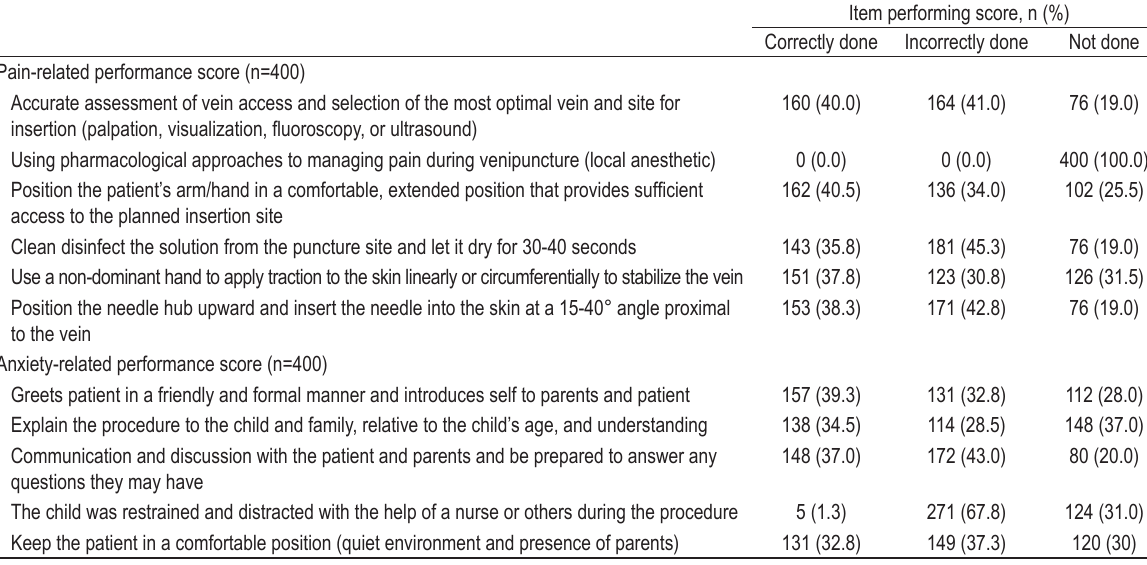
Item performing score, n (%) Correctly done Incorrectly done Not done